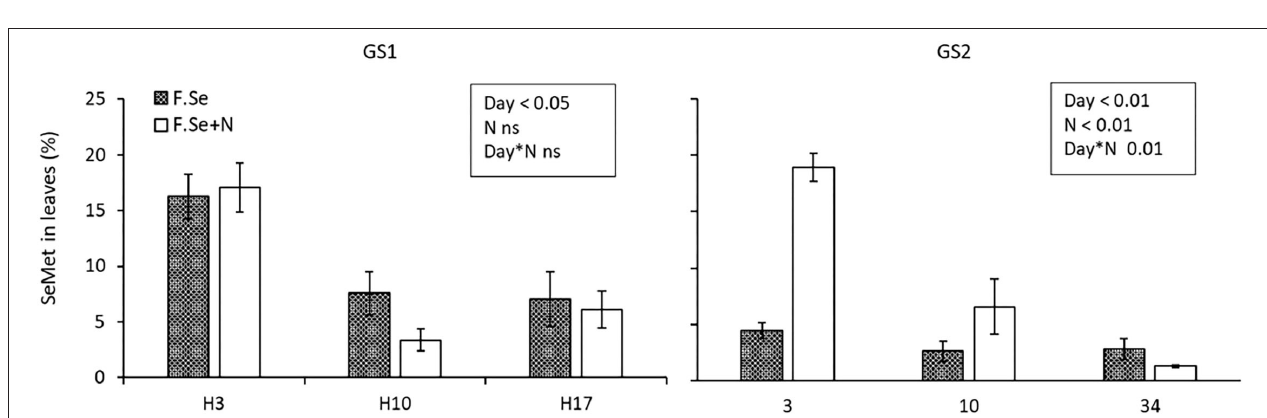
FIGURE 5 | The concentration of SeMet in leaves that were treated with foliar Se and foliar Se + N at stem elongation (GS1) and heading stage (GS2). Results show averages and error bars represent SEs ( n = 4). The p -values displayed on the graph show statistical significance from a two-way ANOVA.